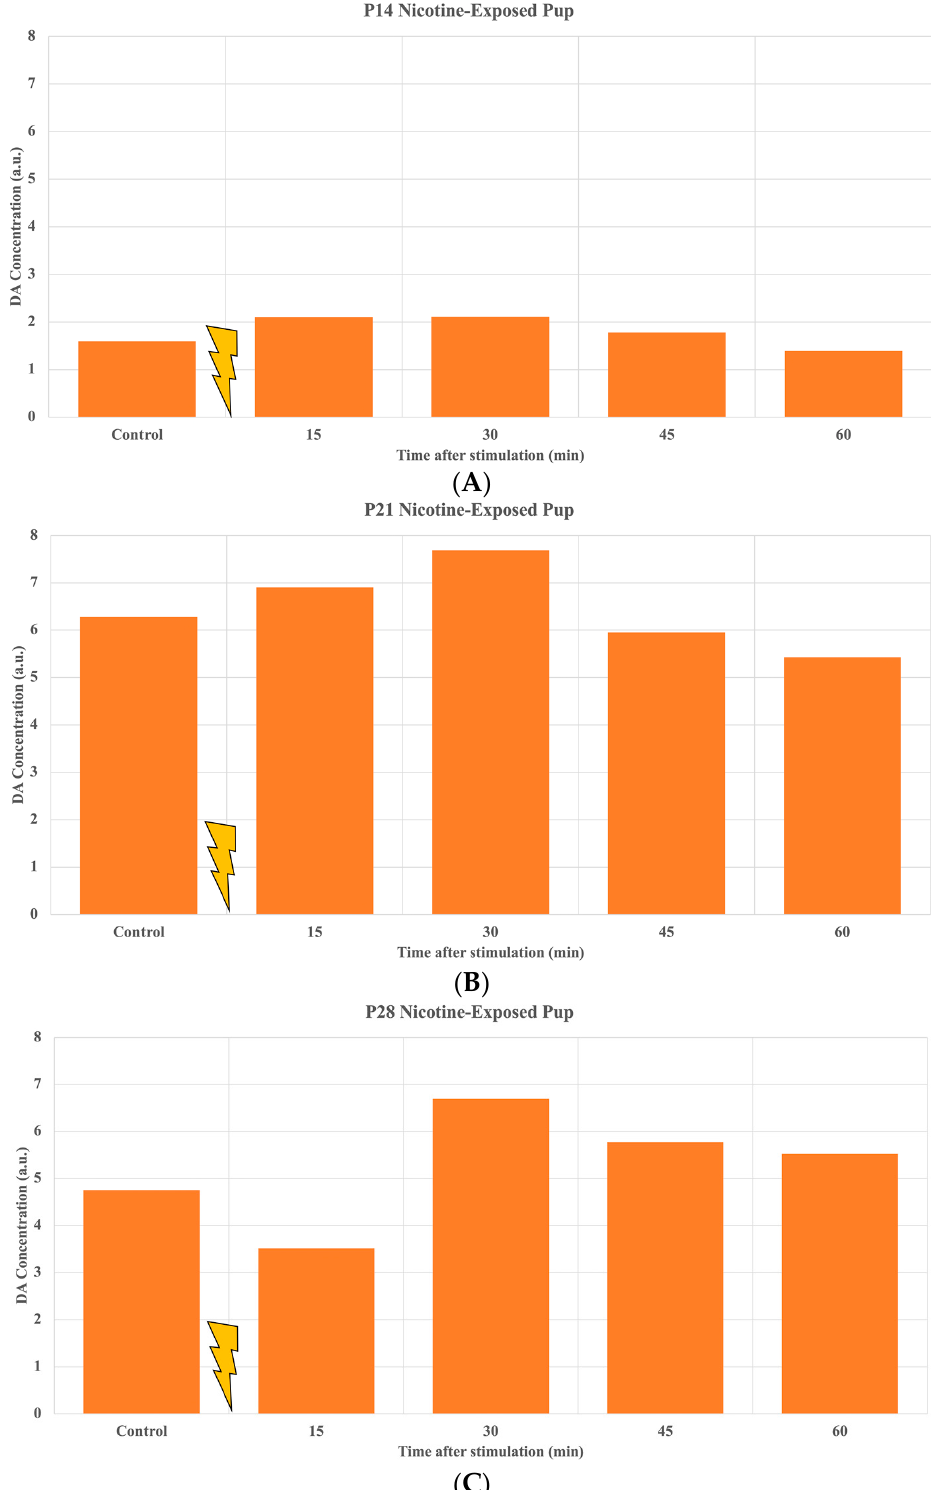
Figure 1. DA in NAc before (control) and after (0–60 min) stimulation of the three representative nicotine-exposed rat pups including P14 ( A ), P21 ( B ), and P28 ( C ). Our data demonstrate the increase in DA release into NAc following stimulation of VTA.